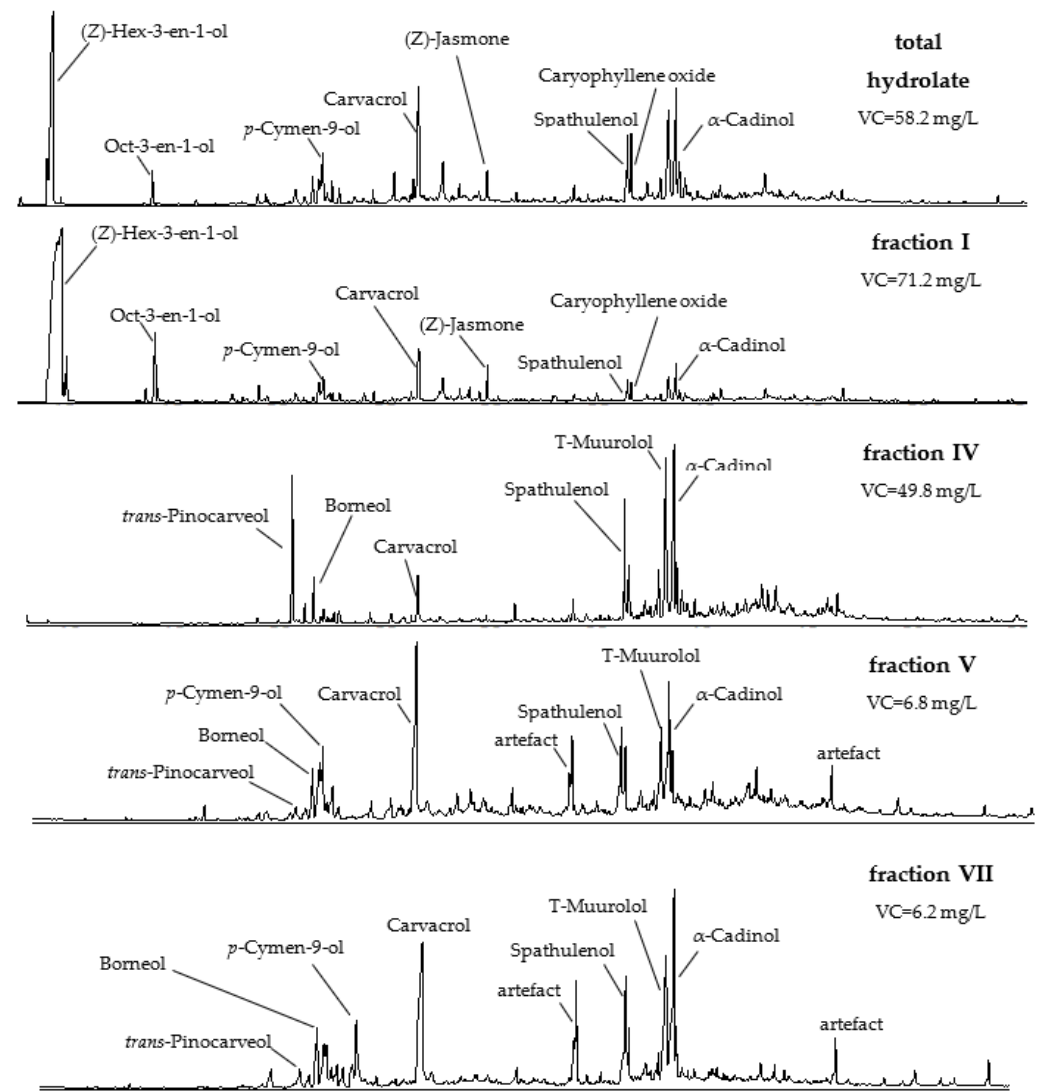
Figure 2. Changes in the profile of the U. dioica L. hydrolate volatile compounds, in total and by fraction (I, IV, V and VII).